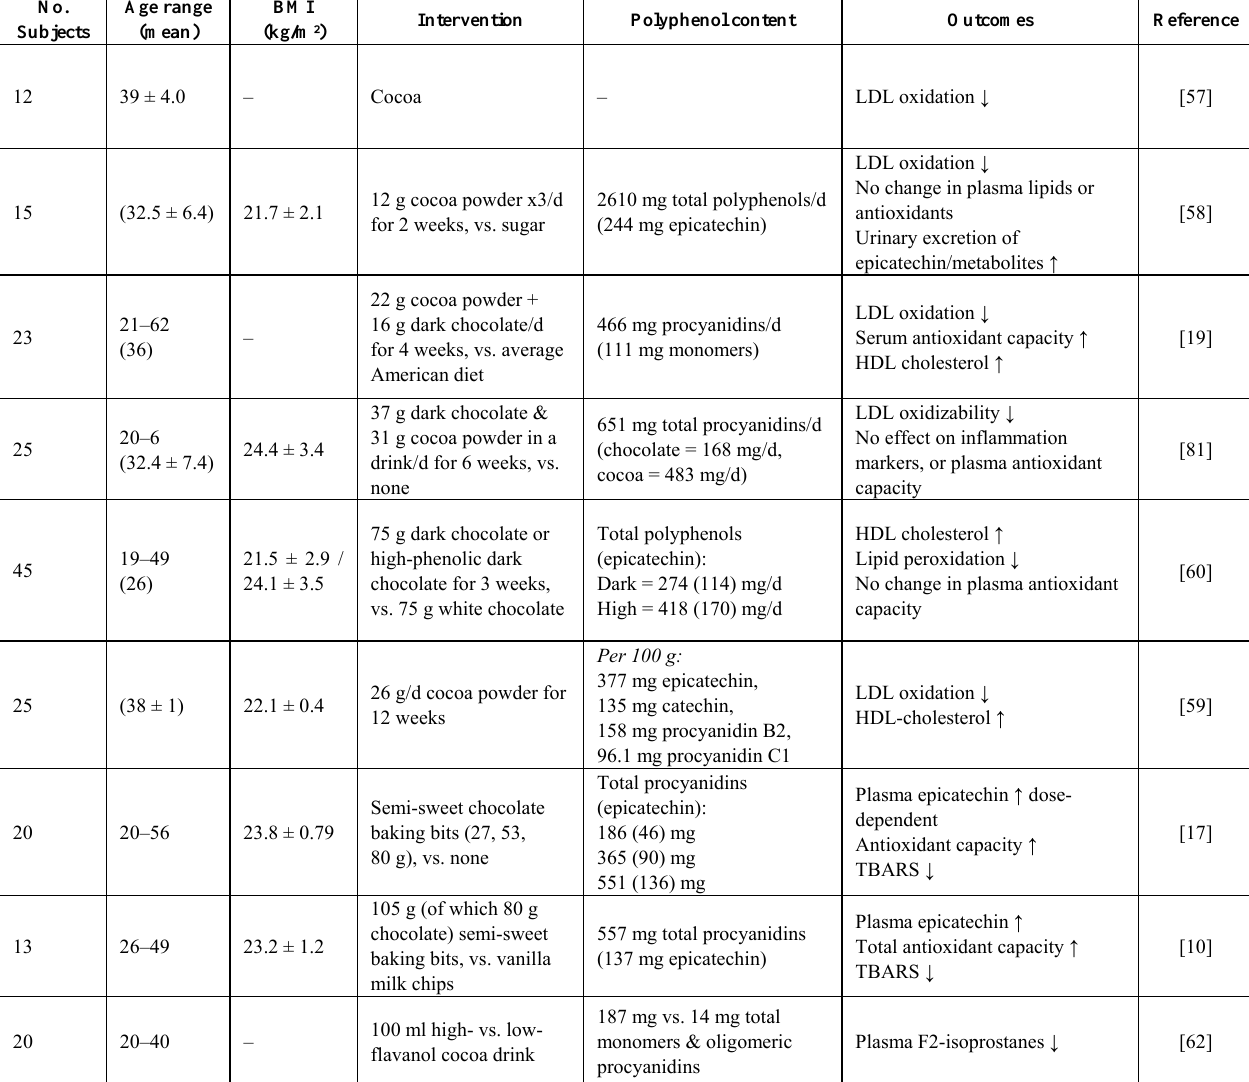
Table 5. Human intervention trials with cocoa and